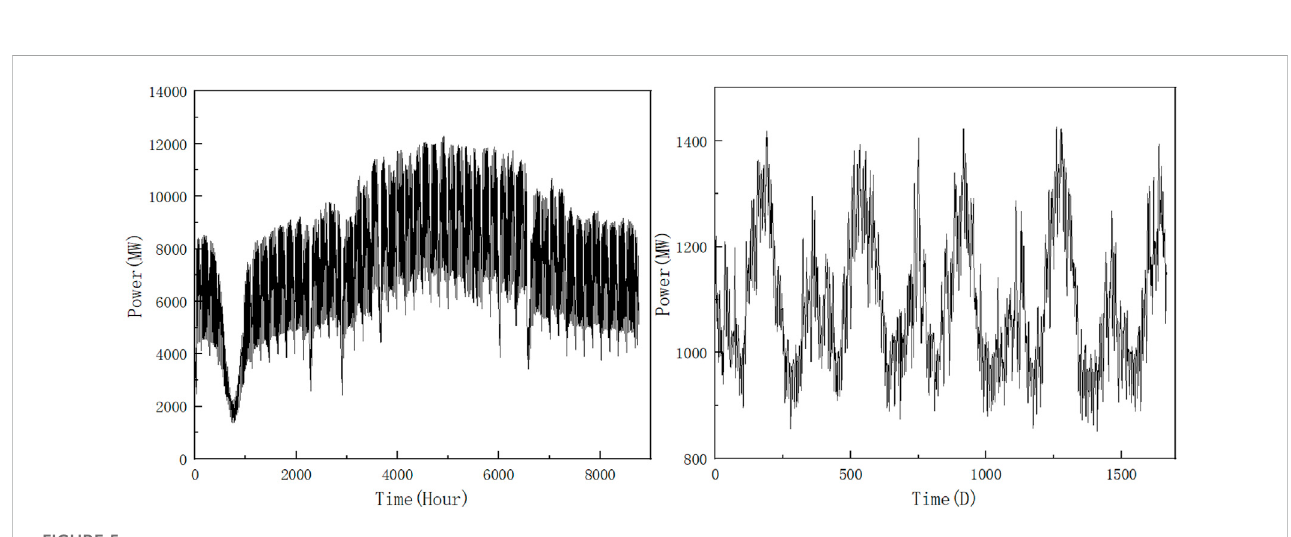
FIGURE 5 Raw load